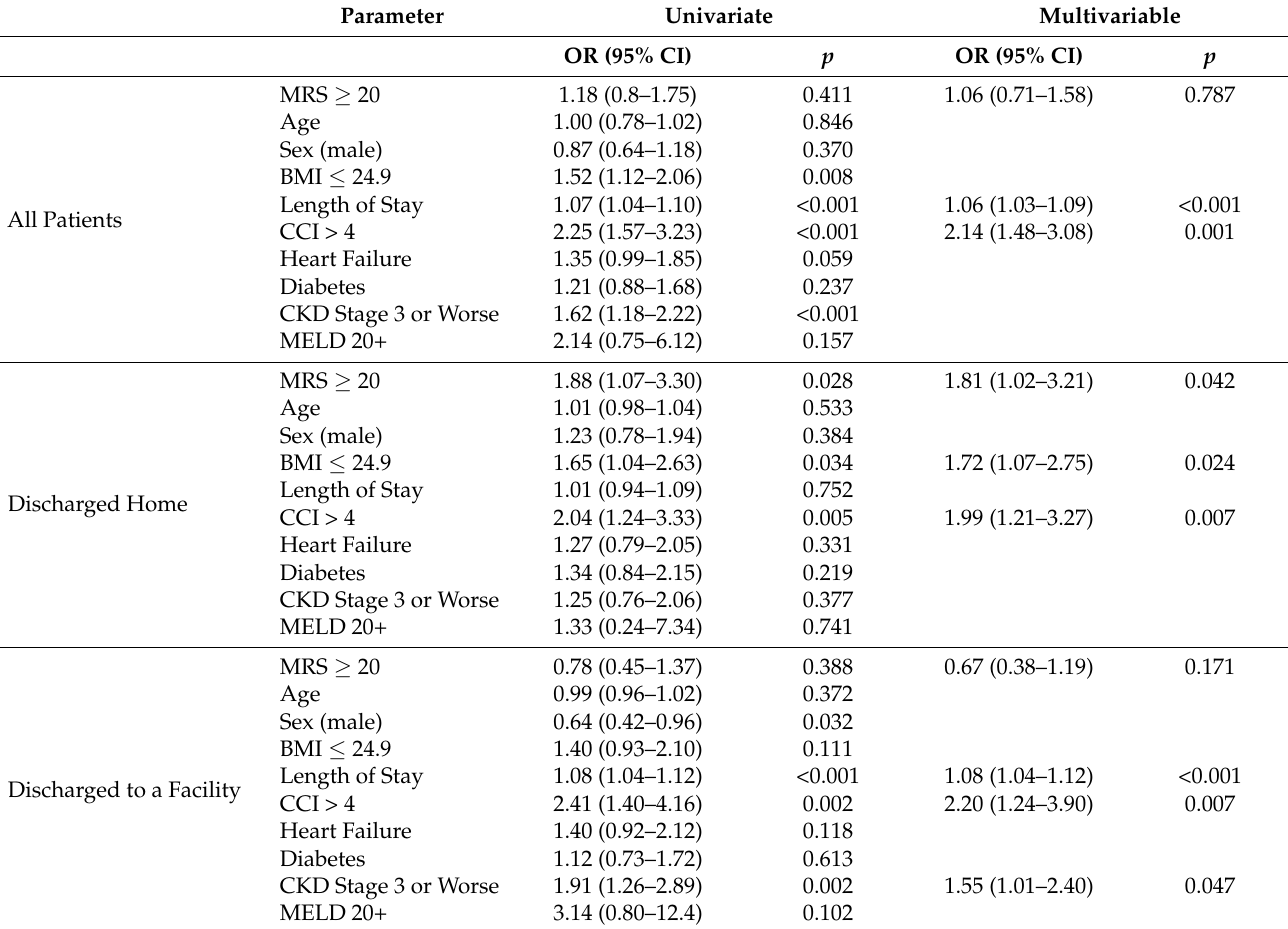
Figure 2. MRS Distribution of All Patients and Subgroups. Table 2. Patient characteristics stratified by risk score and discharge disposition. Table 3. Multivariable Analysis of 30-day Readmission in All Patients and